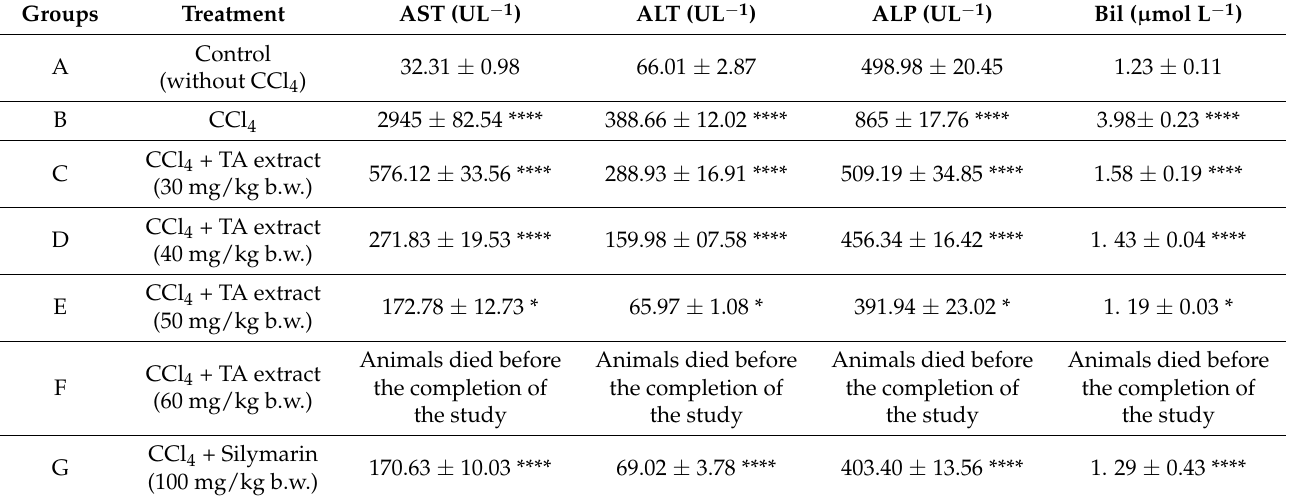
Table 5. Analysis of the serum biochemical parameters in the liver function test after CCl 4 -induced liver toxicity and treatment with varying doses of TA extract (30, 40, 50, and 60 mg/kg b.w.) along with standard silymarin (100 mg/kg b.w.). The data represent the mean value ± SEM of three independent experiments. * p < 0.05, and **** p <